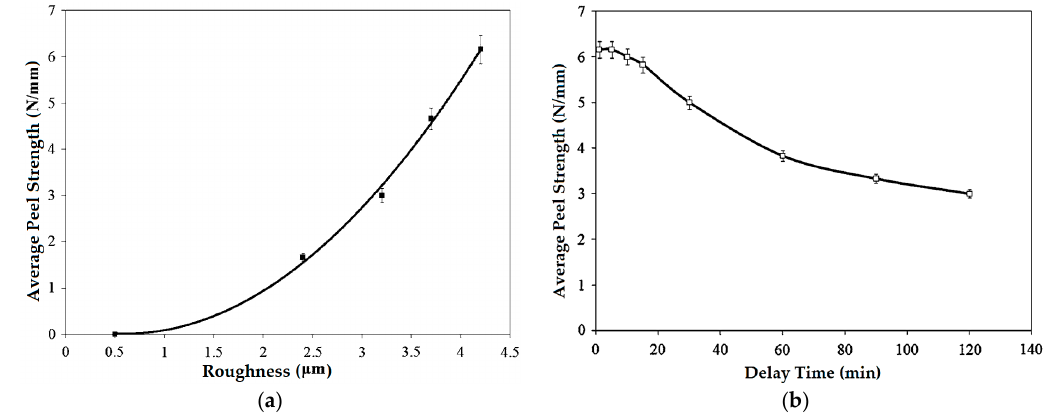
Figure 3. ( a ) Variation in average peel strength of Al strips vs. surface roughness [38], ( b ) variations in average peel strength vs. delay time [38].